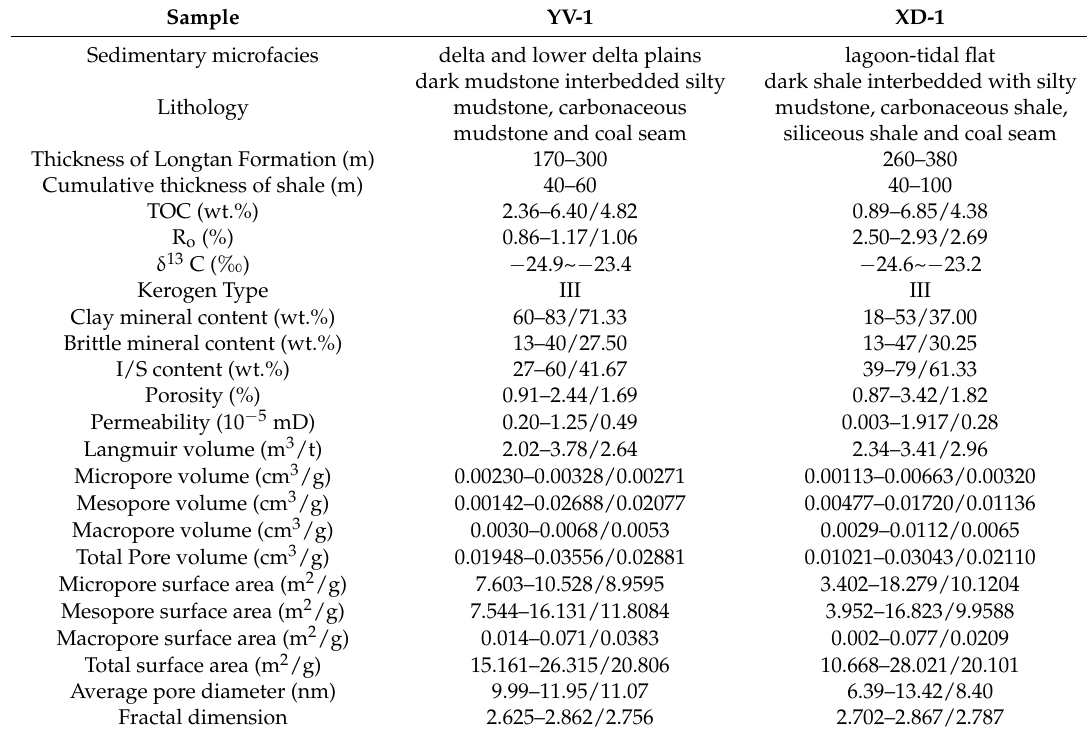
Table 7. Organic geochemical characteristic, mineralogical composition and pore structure parameters of transitional Longtan Shale samples from YV-1 and